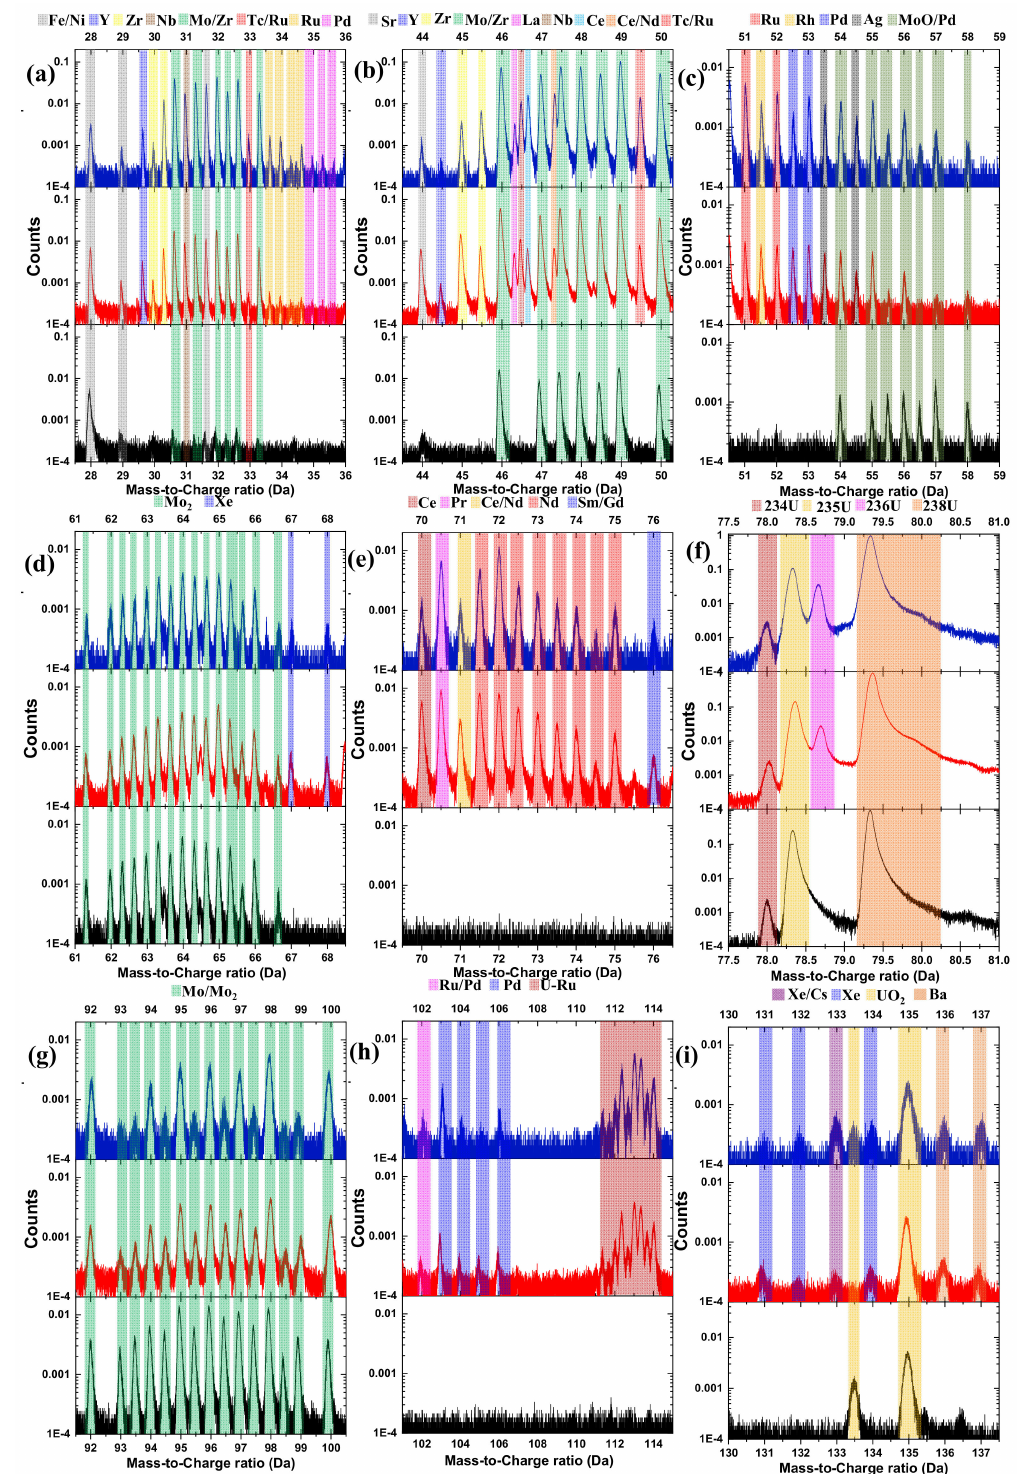
Figure 6. Mass spectrum in the range of 28 to 137 Da from unirradiated U-7 wt.% Mo alloy (black, lower spectrum), M11 at 52% LEU burnup (red, center spectrum), and M14 at 66% LEU burnup (blue, top spectrum). All plots from 3 samples are normalized to 238U 3+ peak. Sub figures from ( a – i ) are from different part of mass spectrum. Different color codes identified above each sub figures are used to identify U, Mo, and individual fission